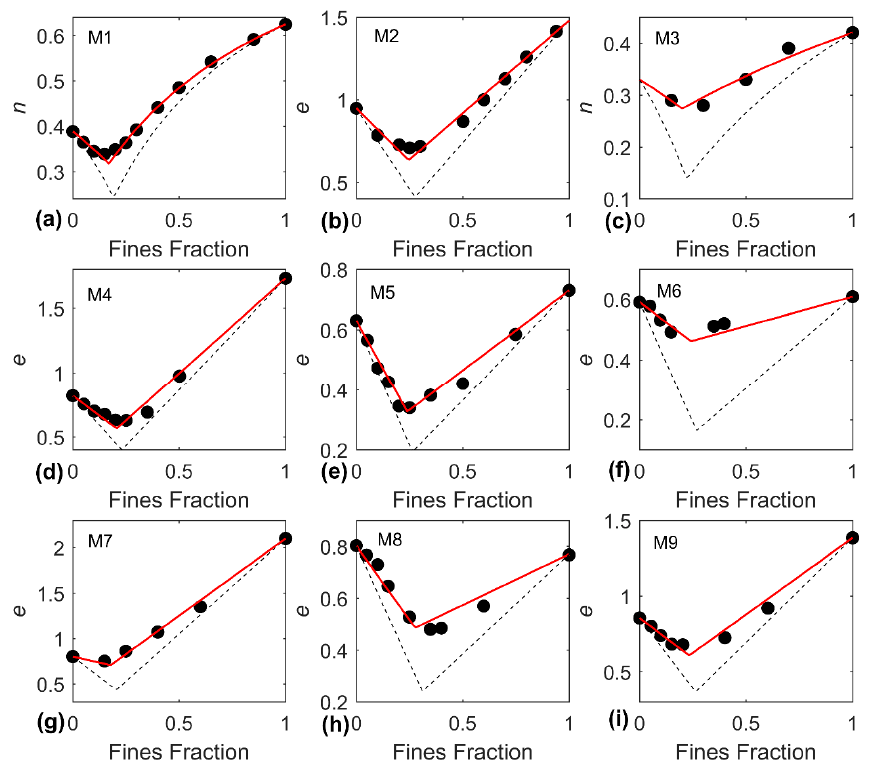
Figure 3. Porosity, n , (or void ratio, e ) as function of fines fraction for mixtures M1 to M9 [( a – i ) respectively] from Table 1. Black circles refer to the experimental data (data sources are provided in Table 1), dashed curve is the prediction of ideal packing [Equations (1)–(4) assuming r = 0], while red curve is the current model prediction [Equations (1)–(6)] assigning p = 0.15.